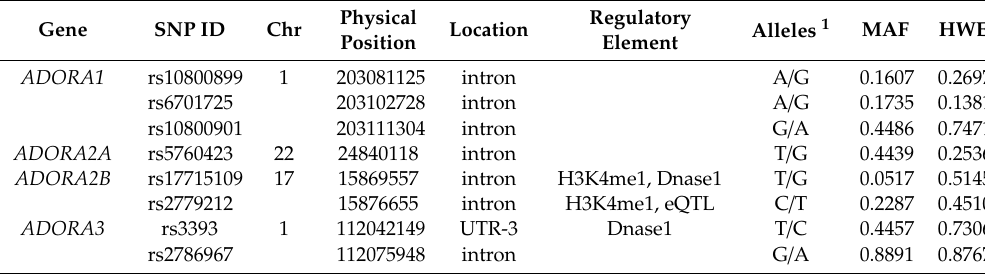
Figure 2. Linkage Disequilibrium (LD) block of genetic variants in the Adenosine Receptor ( ADORA ) gene family. The LD blocks are for variants in ( a ) ADORA1 , ( b ) ADORA2A , ( c ) ADORA2B , and ( d ) ADORA3 loci, respectively. Square boxes indicate SNPs used for further analysis. Table 1. The list of selected SNPs in the Adenosine Receptor ( ADORA ) gene family.